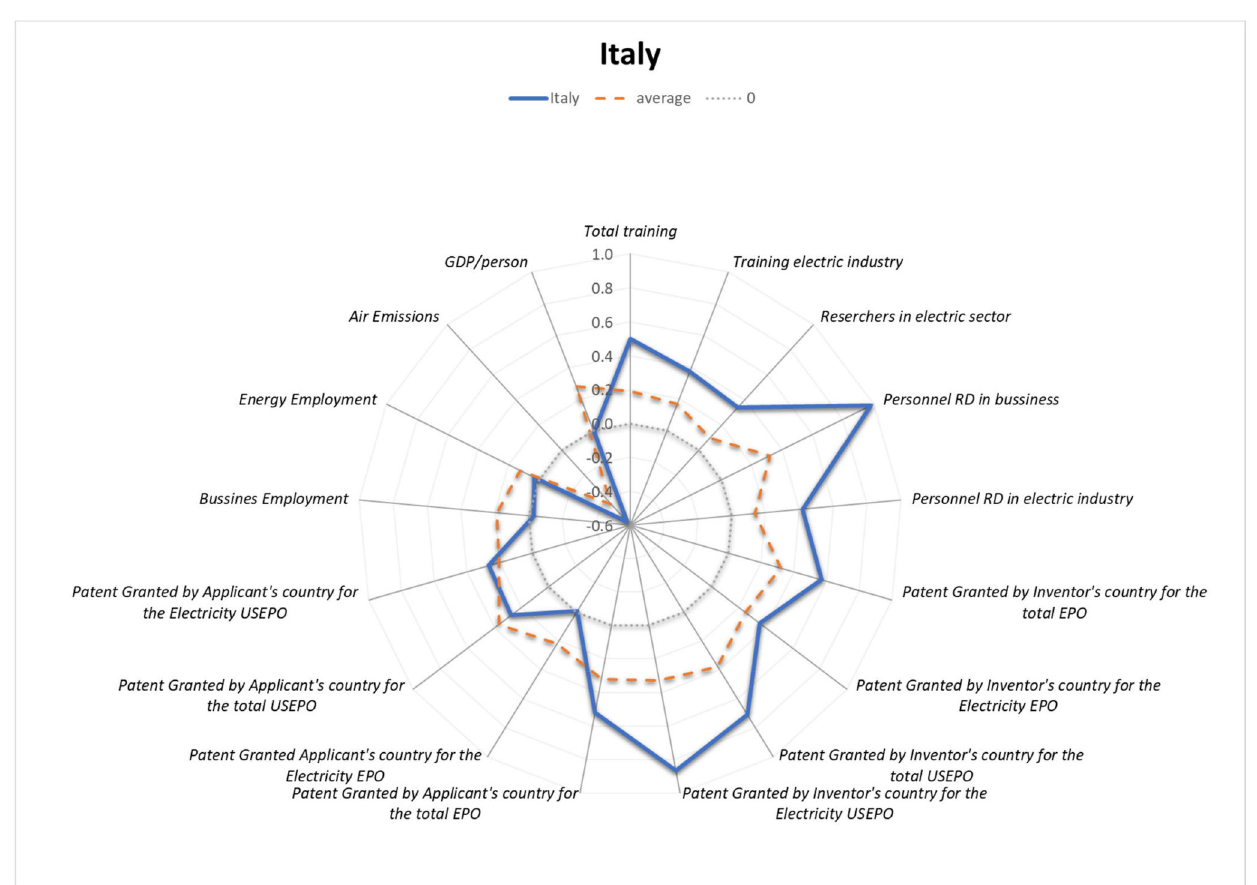
Figure 23. Synergy and trade-off occurrence—IT. Source: Authors’